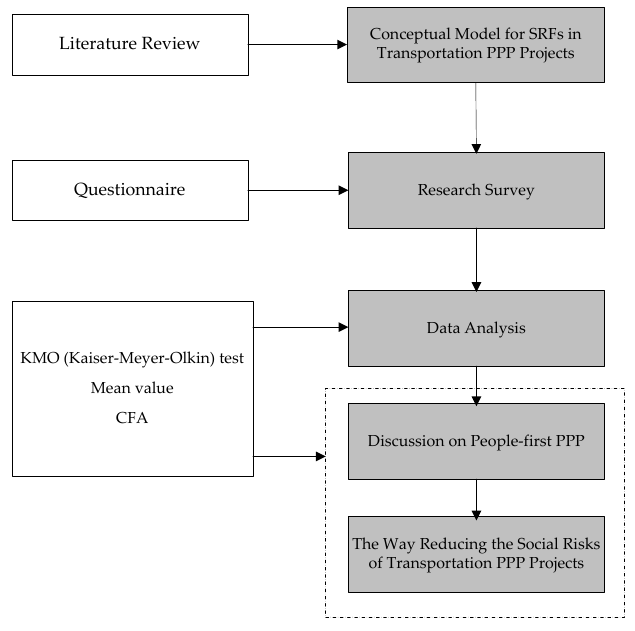
Figure 2. The research method adopted in this study.